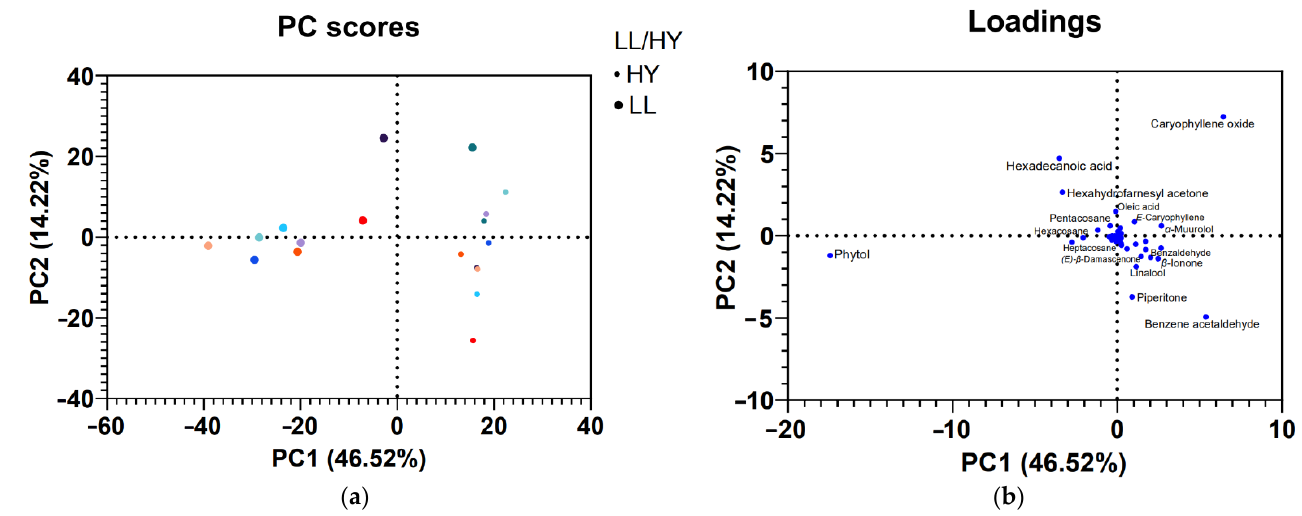
Figure 3. ( a ) PCA score plot for LLs (lipophilic layer) and hydrosols (HY) from HD method; ( b ) PCA loading plots of HD volatiles from the first and second principal component. The color palette represents the same species as in Figure 2a.